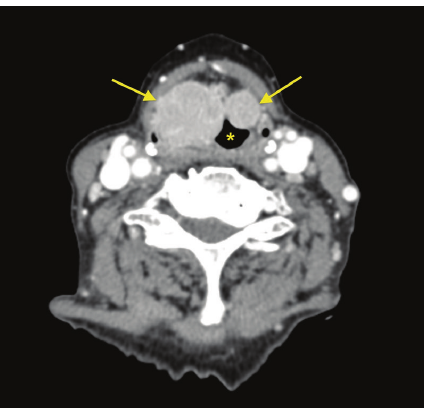
Figure 1: Axial contrast enhanced CT scan at the level of true vocal cords showing bilateral solid paraglottic masses (arrows) narrowing the laryngeal lumen (asterisk).